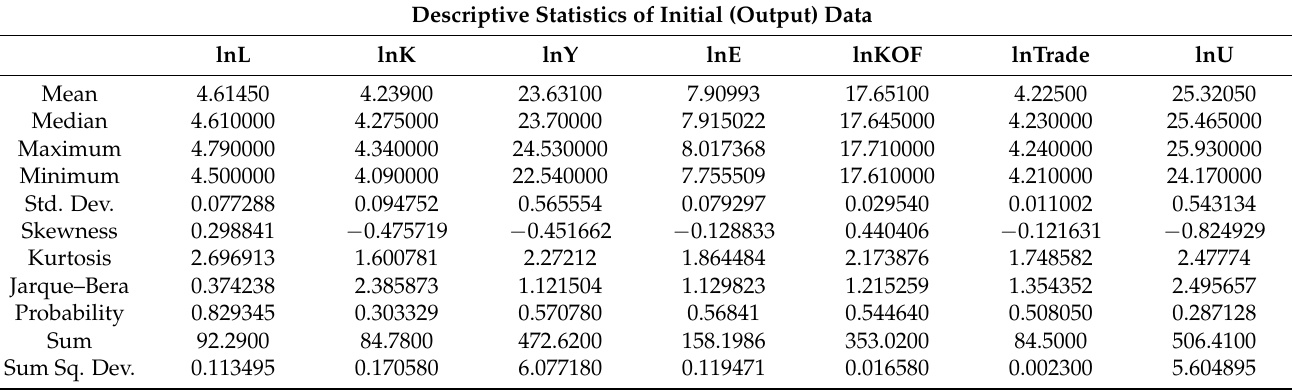
Table 2. Descriptive statistics and correlation matrix of initial data for estimating energy efficiency gaps in the national